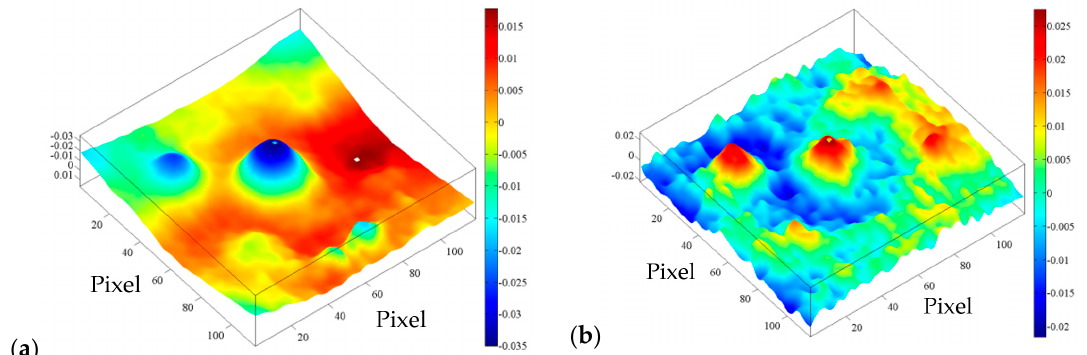
Figure 8. BM 1–1 bottom side, distance 1.5 m: ( a ) EOF 2 ; ( b ) EOF 5.